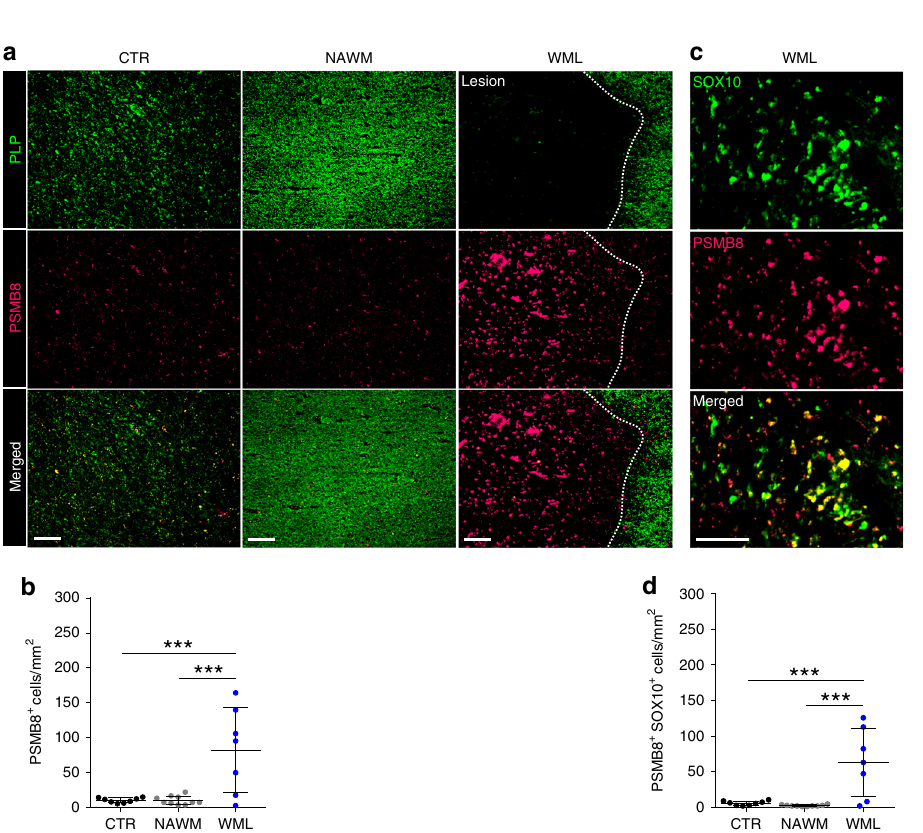
Fig. 10 MS lesions have high PSMB8 expression in oligodendrocytes lineage cells. a Postmortem tissue from healthy controls or MS patients ’ normal appearing white matter (NAWM) and white matter lesions (WML) was analyzed for the immunoproteasome speci fi c subunit, PSMB8 and proteolipid protein (PLP) (scale bar 200 μ m). b PSMB8 staining colocalization with SOX10 staining. c , d Quanti fi cation of imaging. A total of eight healthy controls, ten NAWM and seven WML sections were counted. Signi fi cance was determined by one-way ANOVA analysis followed by Tukey ’ s multiple comparison analysis ( P * ≤ 0.05, ** ≤ 0.01, *** ≤ 0.001, **** ≤ 0.0001). Error bars in all graphs represent standard